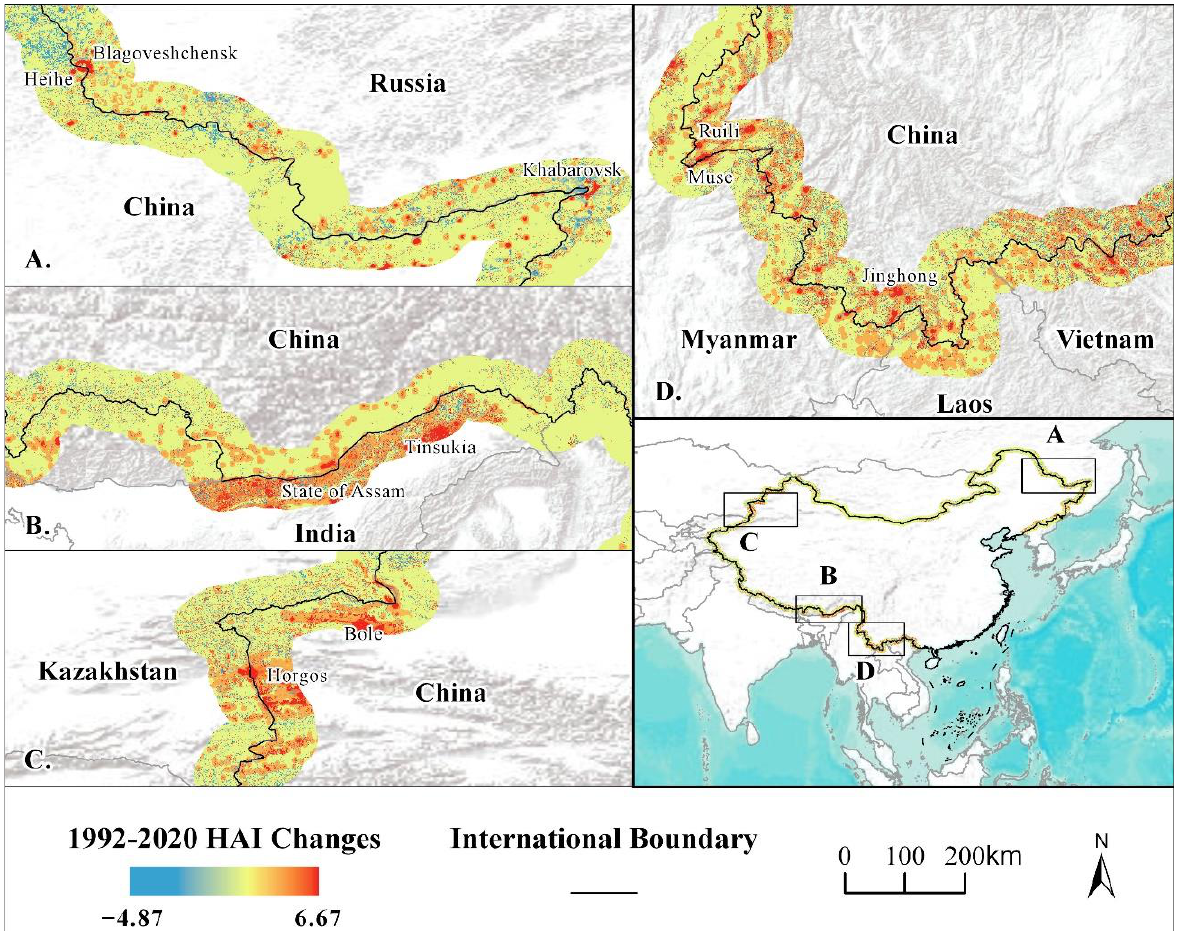
Figure 6. HAI changes in selected regions, 1992 – 2020. ( A ). The Sino-Russian border area, including the Fuyuan Delta, Heihe; ( B ). The east part of the Sino-Indian border area, including Assam in India and Nyingchi in China; ( C ). China – Kazakhstan border area, including Bortala Mongolian Autonomous Prefecture and Yining city in China, and the Almaty Region in Kazakhstan; ( D ). China and the Indo-China Peninsula border area, including the cross-border regions between China and Myan-mar, Laos, and Vietnam.